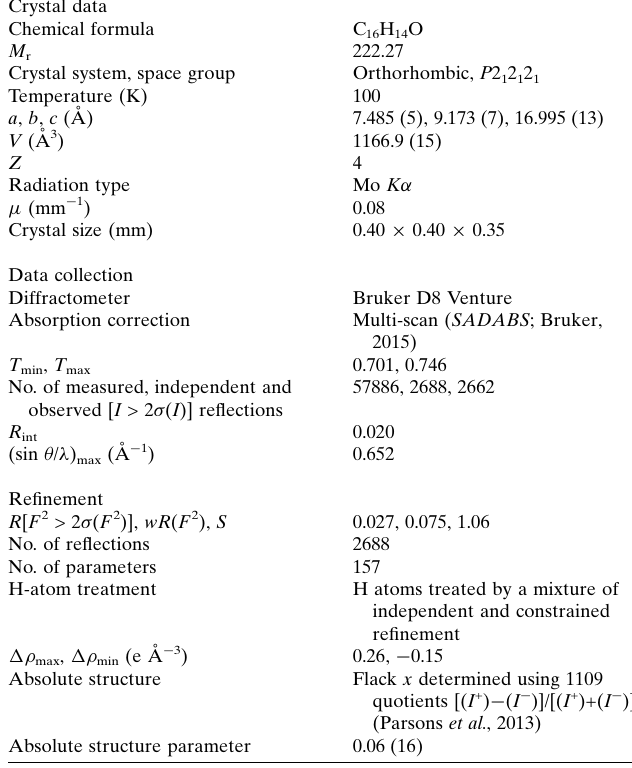
Table 1 Experimental details.